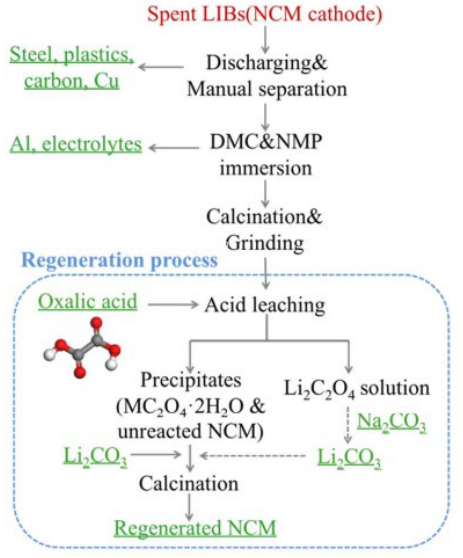
Figure 4. Schematic illustration of the whole regeneration processes of NCM cathode materials from waste LIBs. Reprinted with permission from Ref. [52], Copyright 2018, American Chemical Society.